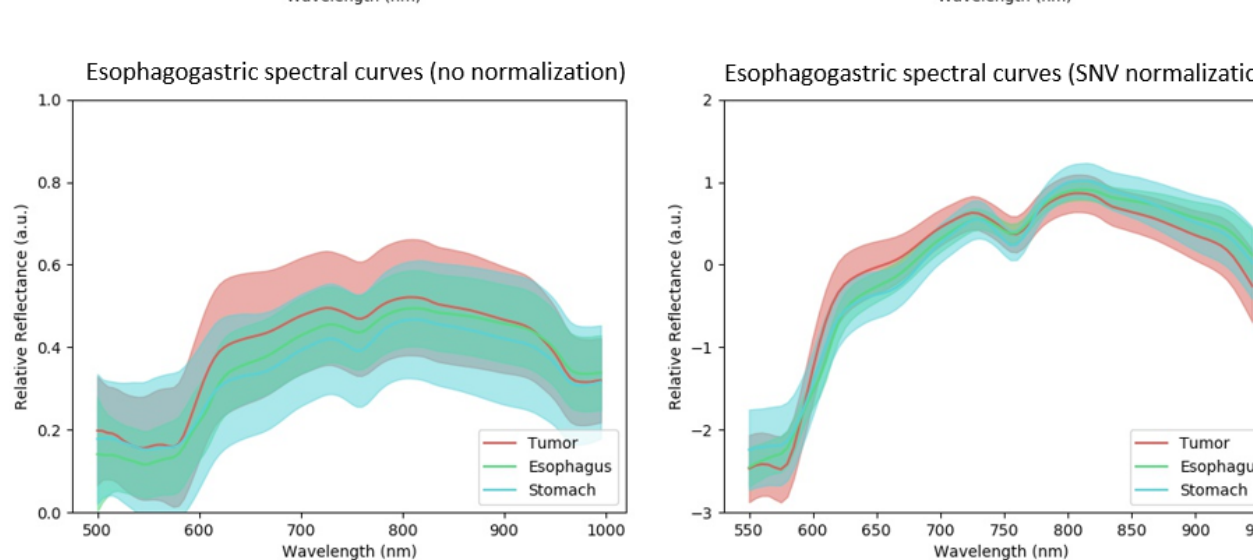
Figure 2. Spectral curves for colon and esophagogastric datasets with and without SNV normalization. Solid curves show the mean spectral curves, and filled regions show 1 standard deviation from the mean